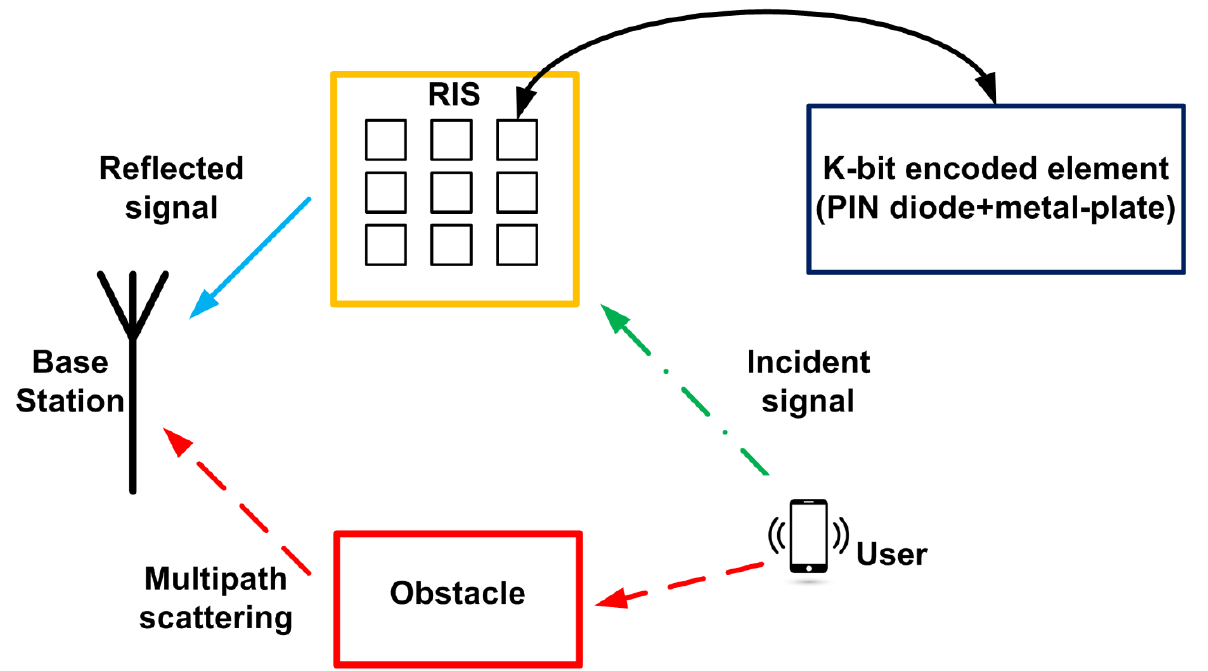
Figure 2. RIS assisted communication model for uplink cellular network. Table 3. RIS performance parameters comparison.